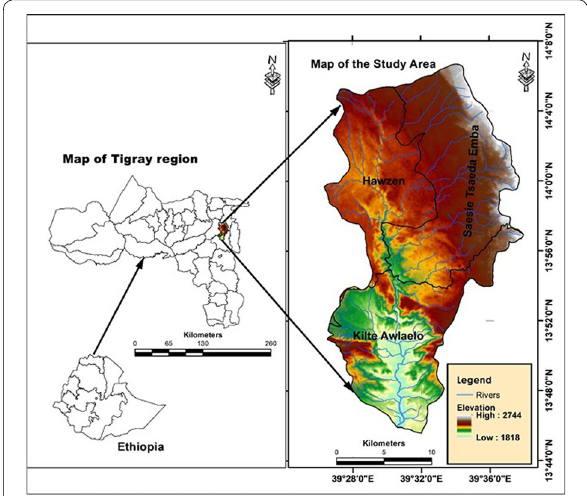
Fig. 1 Location and digital elevation model of Middle Suluh River